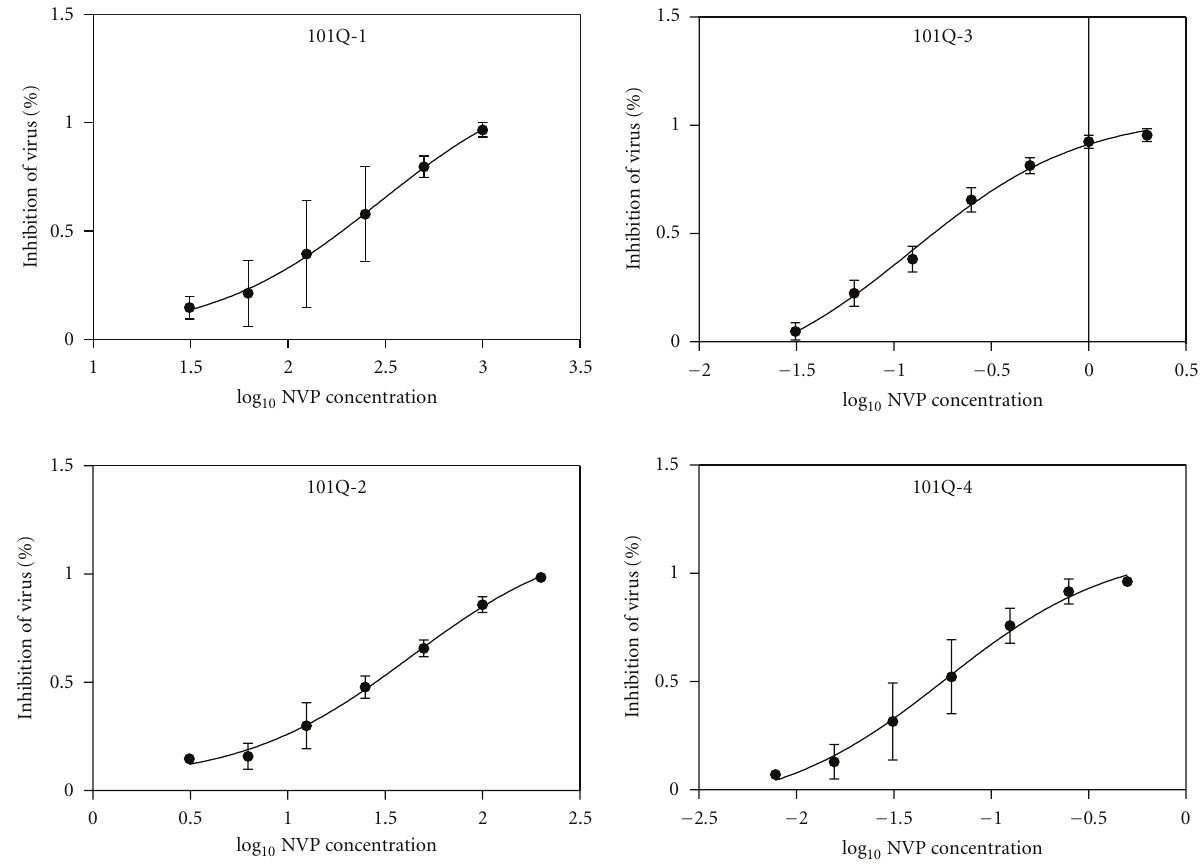
Figure 1: The curves of percent inhibition of virus 101Q-1 ∼ 101Q-4 to log 10 NVP concentration. Table 3: The complete set of di ff erences from consensus B (from 99 to 313 AA in pol region). Position of AA in pol Virus